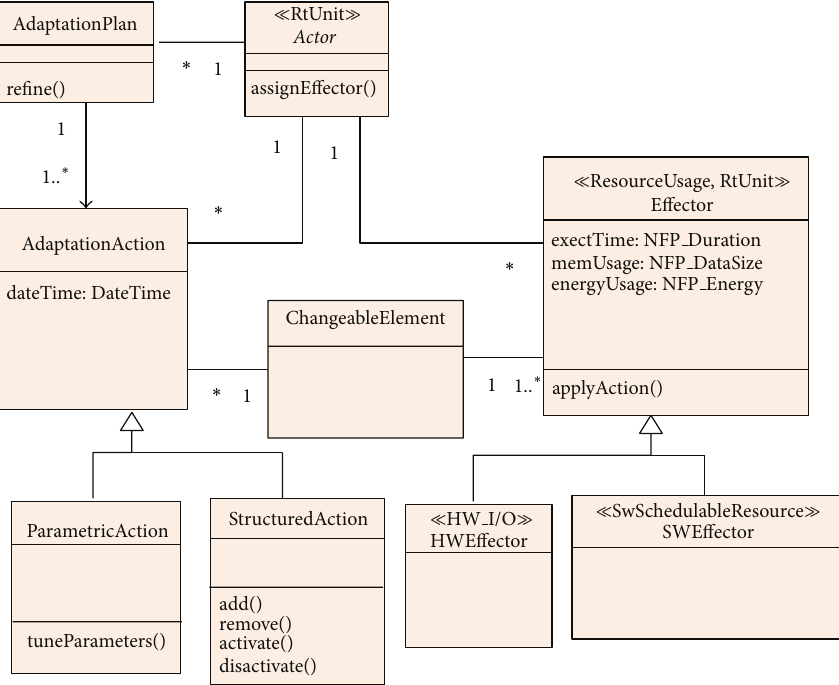
Figure 9: Structural view of the RTE Actor